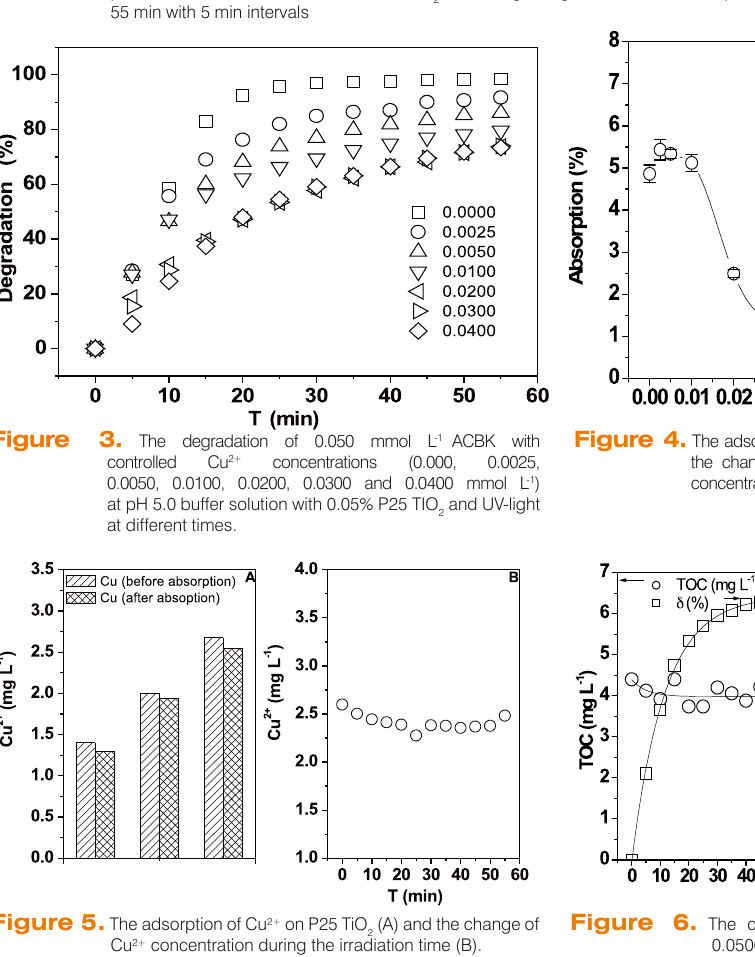
Figure 5. The adsorption of Cu 2+ on P25 TiO Figure 6. The change of TOC and degradation efficiency of (A) and the change of 2 Cu 2+ concentration during the irradiation time (B). 0.0500 mmol L -1 ACBK in the absence (A) and presence of 0.0300 mmol L -1 Cu 2+